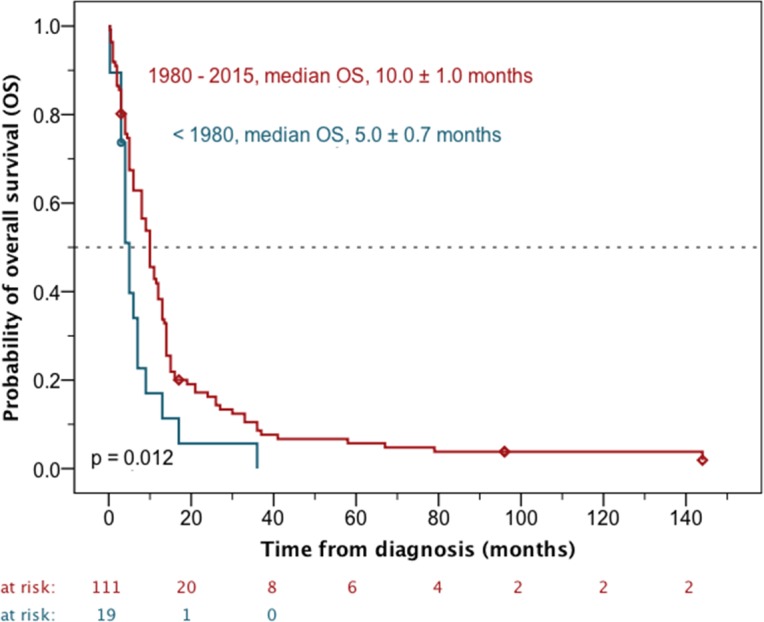
Overall survival (OS) according to the publications before and after 1980.A modest increase in treatment success has been achieved over recent decades.